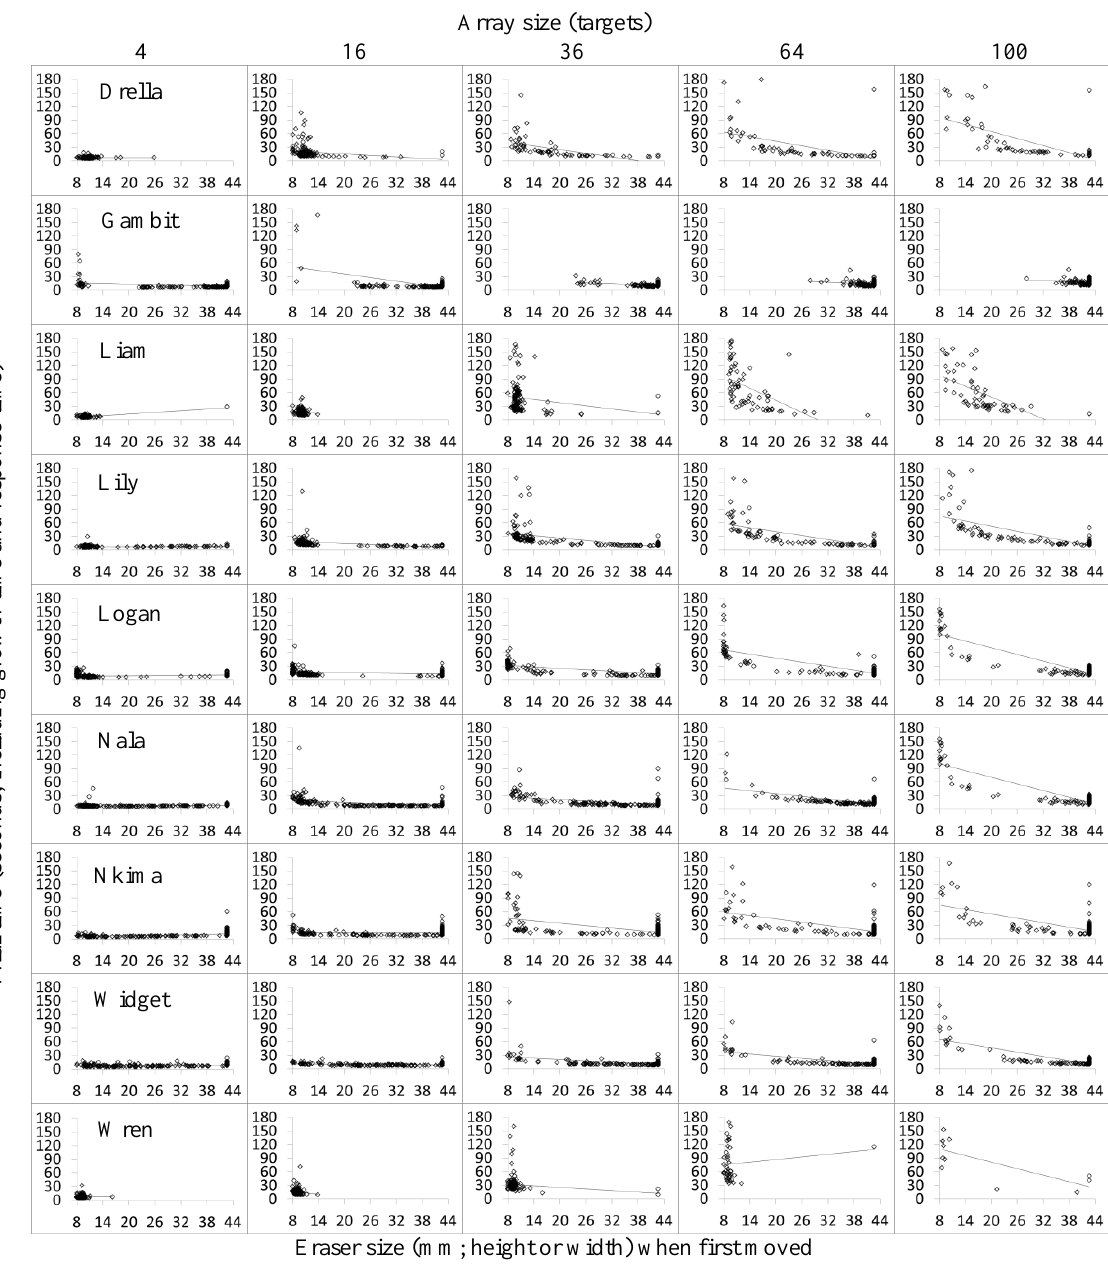
Figure 3 . Scatter plots with trend lines for each correlation between final eraser size and total trial time in Testing Phase 1. Panel (A) includes only rhesus monkey plots and panel (B) includes only capuchin monkey plots. Each row represents a different monkey (named in the left-most plots) and each column represents a different array size (arranged from smallest to